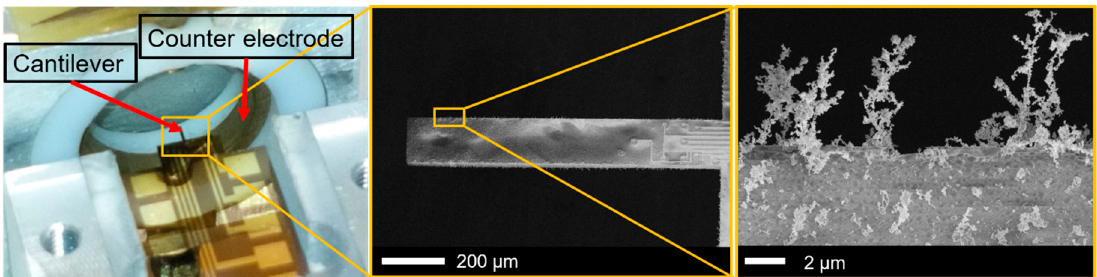
Figure 8. Photograph and SEM images of a cantilever resonator inside a custom-built sampler and with electrostatically collected NPs, respectively.